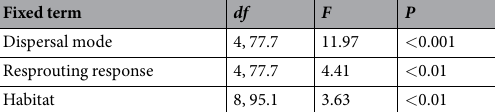
Table 2. Multivariate restricted maximum likelihood (REML) linear mixed model results for bark thickness, diaspore size, specific leaf area and wood density with dispersal mode, resprouting response to fire and habitat as fixed effects. All of the trait response variables were ln-transformed to improve homoscedasticity.